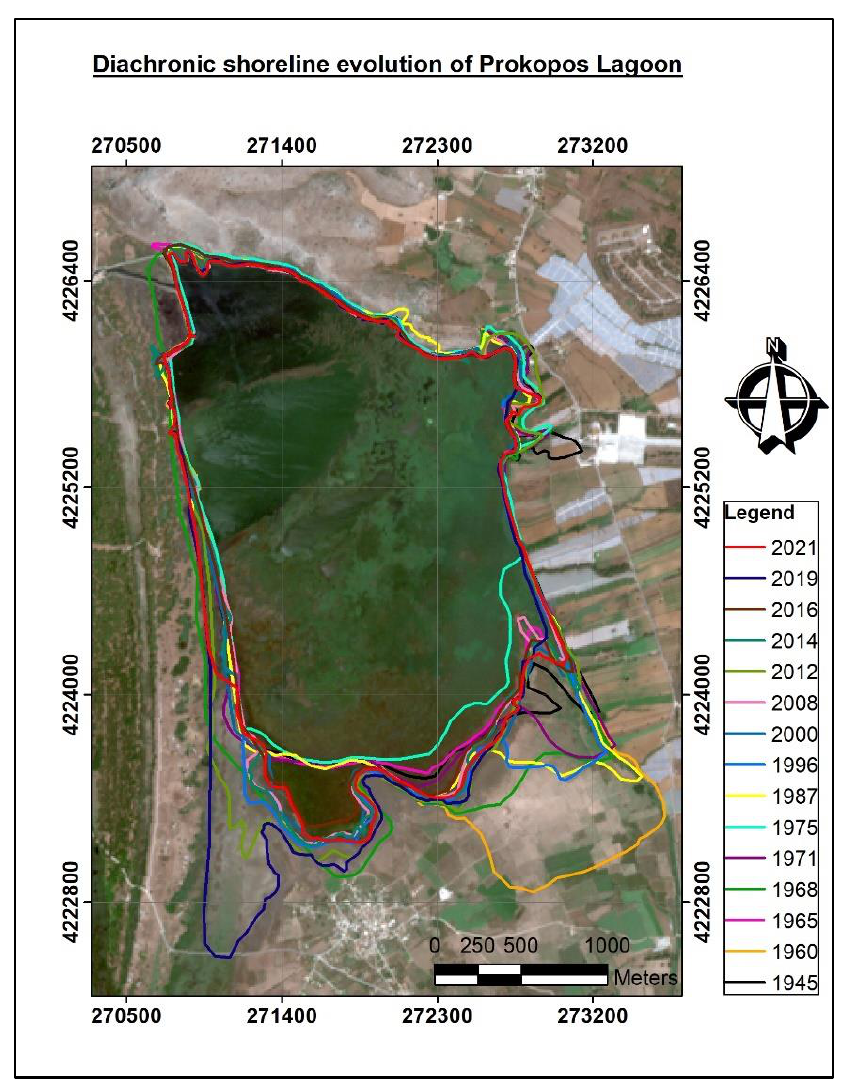
Figure 4. Diachronic shoreline evolution of the Prokopos Lagoon. Basemap of 2021. Table 3. Morphometric parameters of the Prokopos Lagoon.